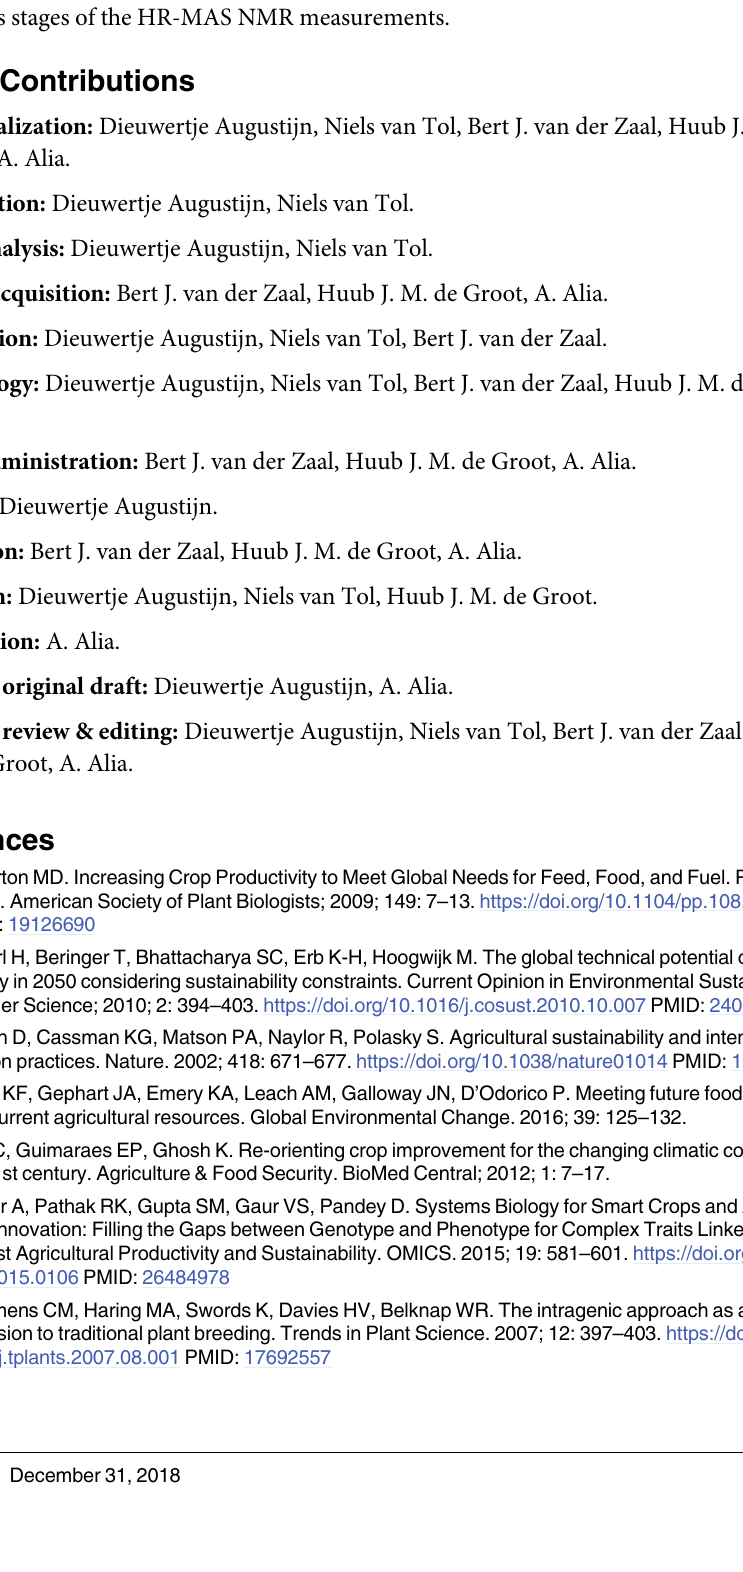
S2 Table. Measured metabolites in leaves of Col-0, VP16-02-003 and VP16-05-014 plants and their chemical shift assignment in 1H HR-MAS NMR